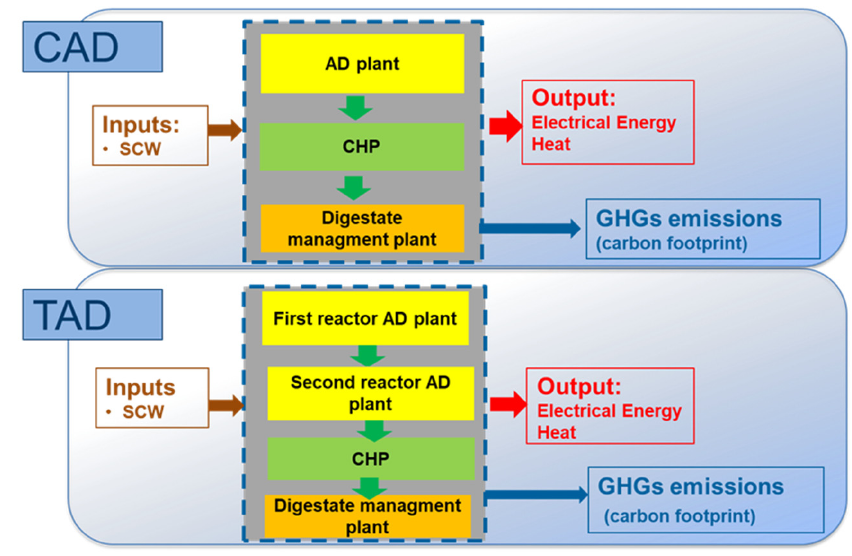
Figure 4. System boundaries of the CAD and TAD